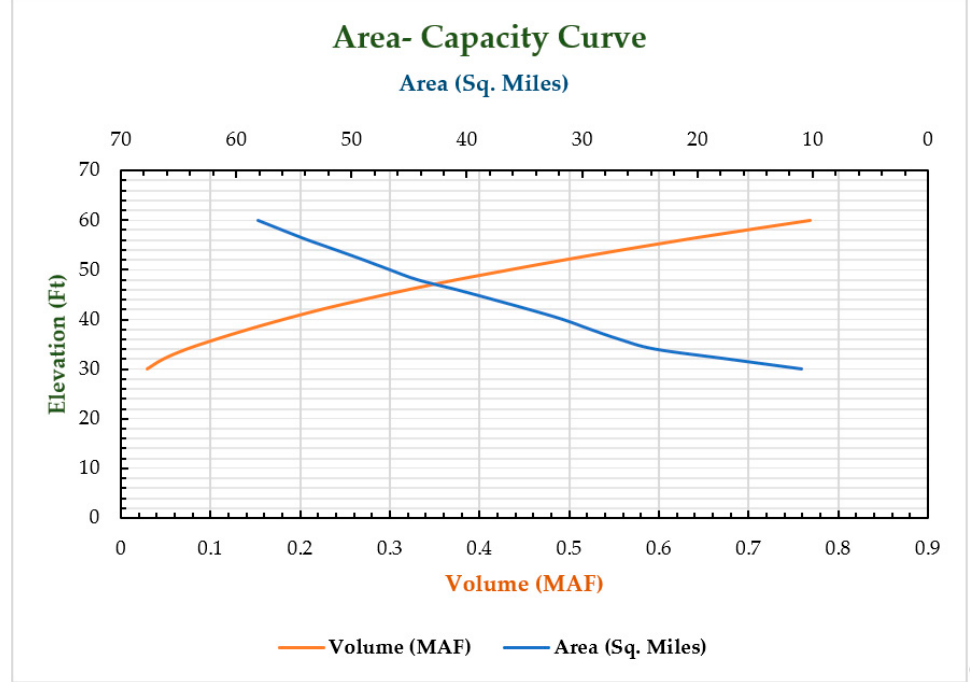
Figure 7. Area, volume, and elevation curve of Keenjhar Lake.